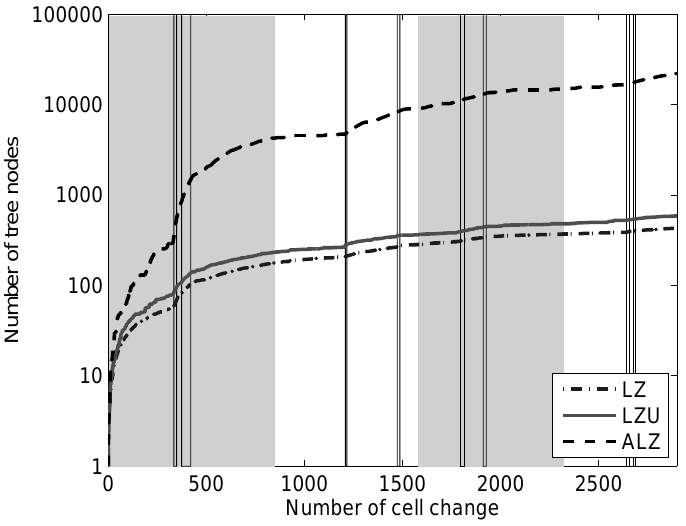
Figure 7. Node count of different trees (log scale).